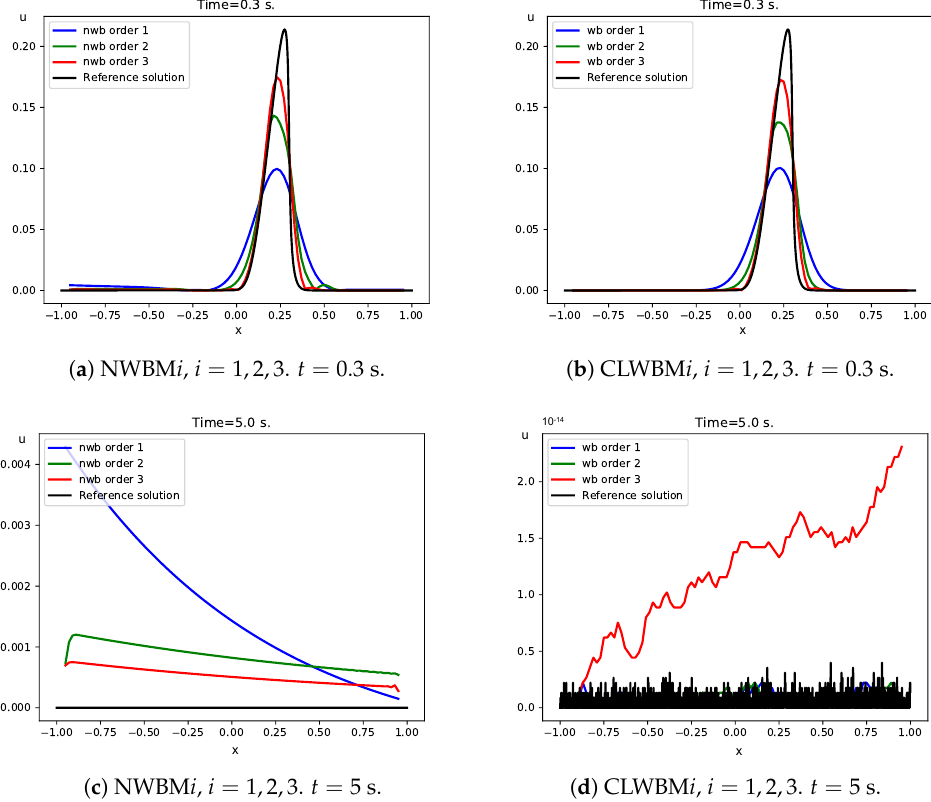
Figure 3. Test 2.2. Reference and numerical solutions: differences with the stationary solution at times t = 0.3,5 s for a 100-cell